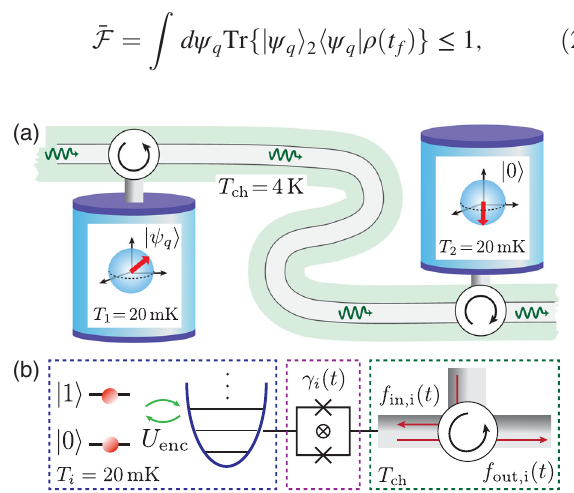
FIG. 1. (a) Sketch of a thermal quantum network, where two nodes (for example, two superconducting qubits located inside separated dilution refrigerators) are connected via a unidirectional quantum communication channel at finite temperature T (b) For the implementation of a noise-resilient transfer protocol, the qubit state is first mapped onto an intermediary oscillator. The oscillator is then coupled to the incoming and outgoing fields of t Þ and f t Þ , via a tunable decay rate γ the channel, f in ; i ð out ; i ð which can be realized, for example, by a flux-tunable quantum interference device [45 – 47].